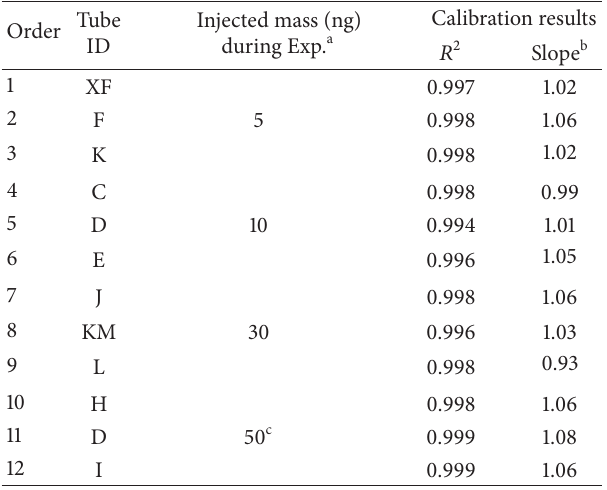
Table 1: Basic information concerning the adsorption tubes used in our